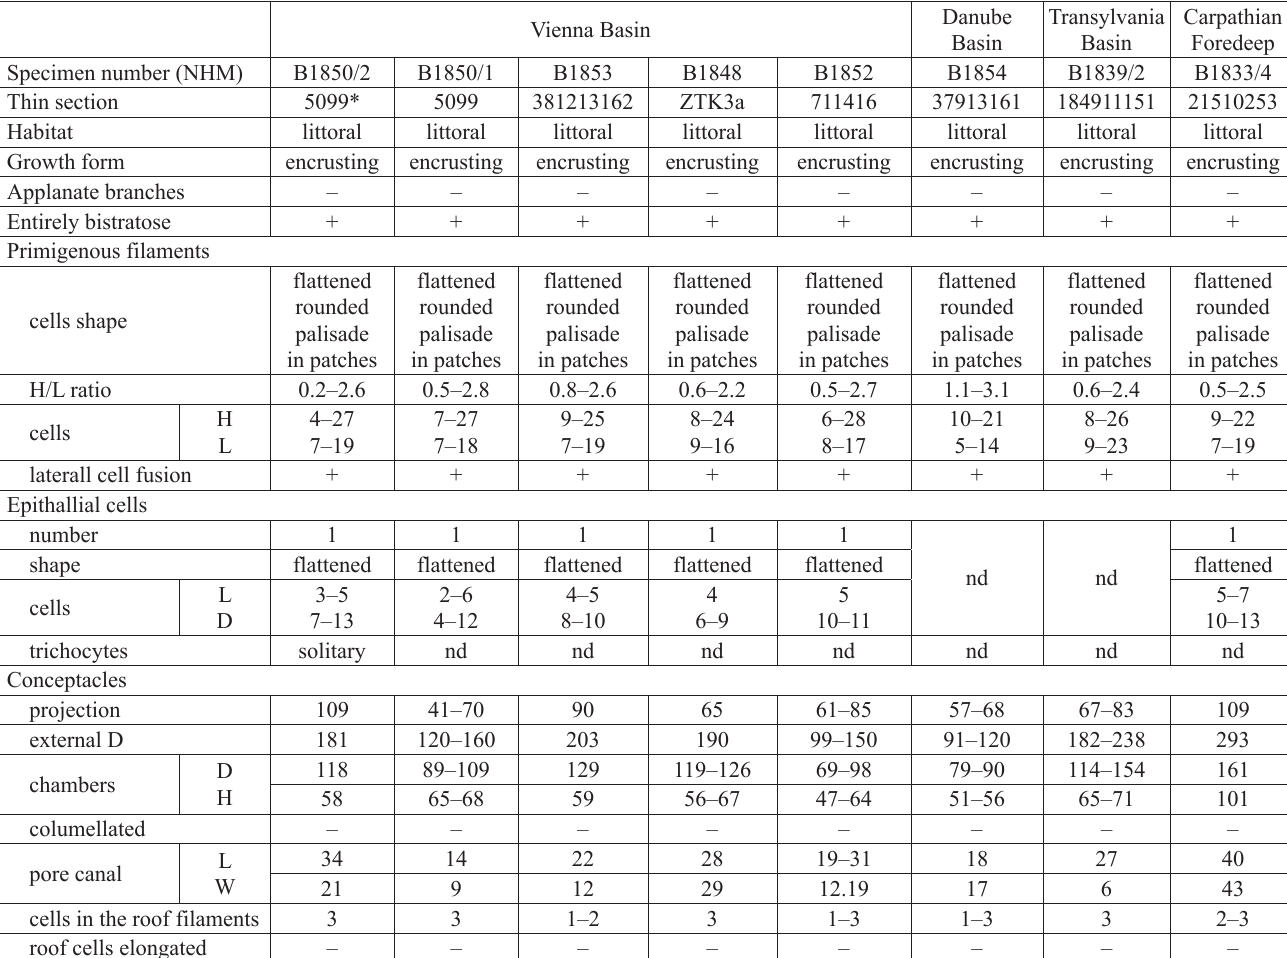
Table 7. Comparative table of selected Hydrolithon minus Johnson, 1964 specimens. * marks gametangial or carpogonial-carposporangial plants. Abbreviations: D, diameter; H, height; L, length; W, wide; nd, no data; “+” presence and “–” absence of character. All measurements in μ